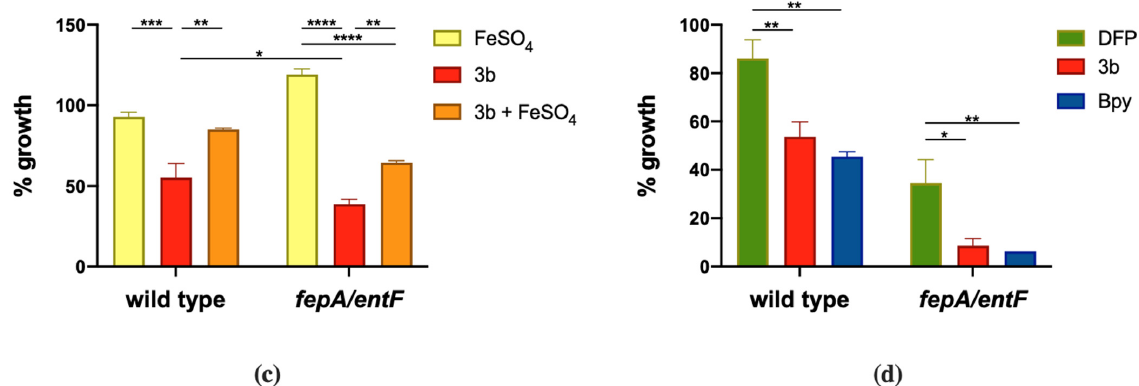
Figure 5. Effects of compound 3b on STM. ( a ) Dose-response of STM grown in LB medium (ctrl) with different amounts of compound 3b as indicated in the legend. Statistically significant differences between ctrl and treatments at the end point of the curves are indicated (two-way ANOVA and Tukey’s multiple comparison test; # p < 0.005). ( b ) Western Blots of IroB protein from strain SA213, grown for 18 h in LB supplemented with FeSO 4 (0.2 mM), Bpy (0.1 mM) or compound 3b (1 mM). Cat protein is indicated as internal loading control. ( c ) and ( d ) STM wild type and fepA/entF strains were grown in ( c ) LB supplemented with FeSO 4 (0.5 mM), compound 3b (1 mM) or both and in ( d ) M9 minimal medium supplemented with DFP (0.2 mM), compound 3b (0.2 mM) or Bpy (0.2 mM). Optical densities were measured after 14 h and % of growth was calculated taking the growth of untreated strains as 100%. Statistical significance (two-way ANOVA and Sidak’s multiple